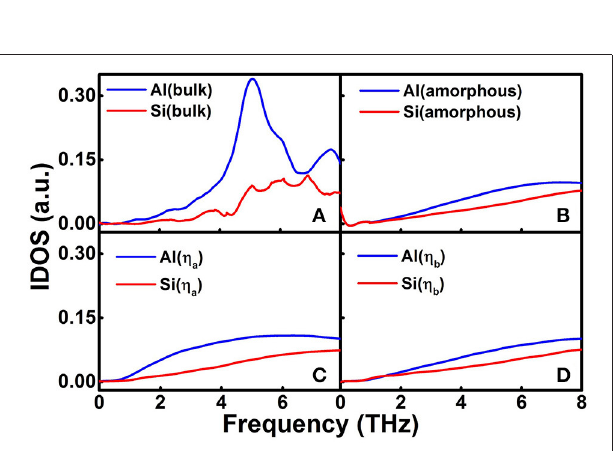
FIGURE 3 | (A) DOS of Al and Si in bulk crystals; (B) DOS of amorphous Al and Si; (C) IDOS of the structure (A) with a system length as 16.473nm; (D) IDOS of structure (B) with a system length as 16.473nm.